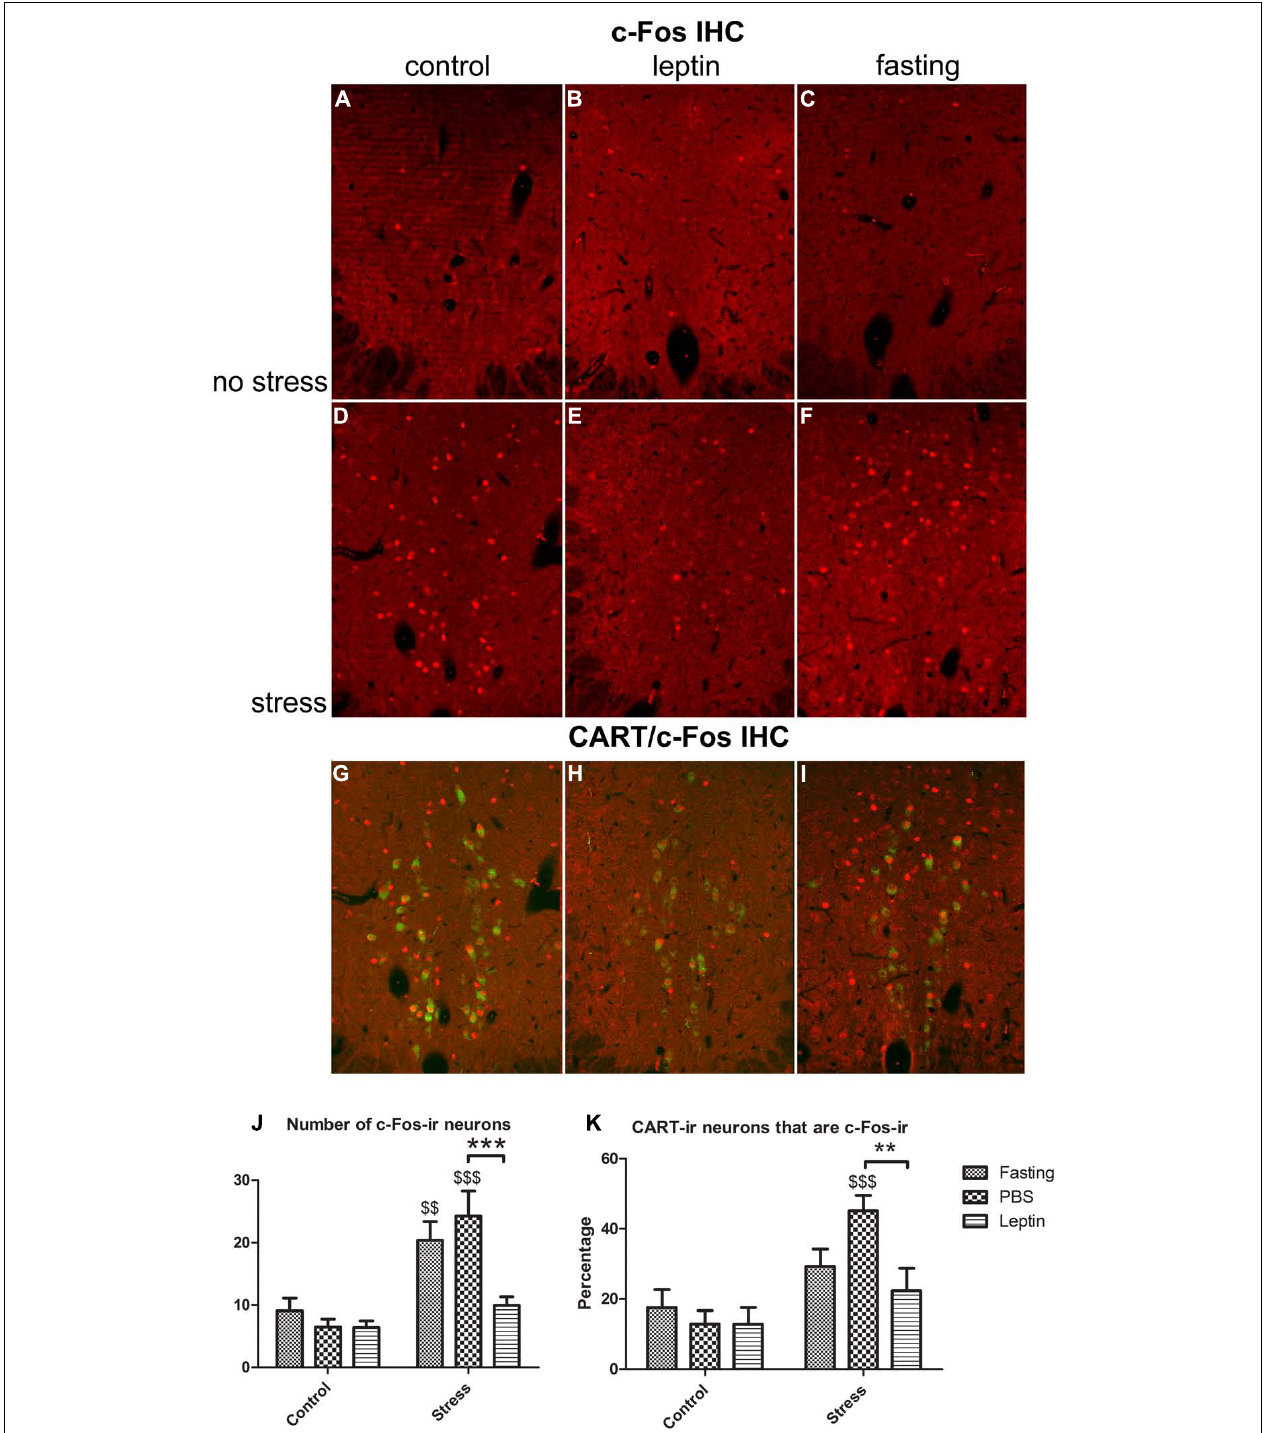
FIGURE 4 | Activation of EWcp CART expressing neurons by restraint stress. (A–C) c-Fos-ir in fasting, PBS-injected and leptin-injected rats, (D–F) the same three treatments, respectively, but stressed. (G–I) Merged images of fluorescent double labeling showing CART- and c-Fos-ir in EWcp neurons. (J) Quantitative analysis of stress-induced activation of EWcp neurons and (K) percentage of CART neurons